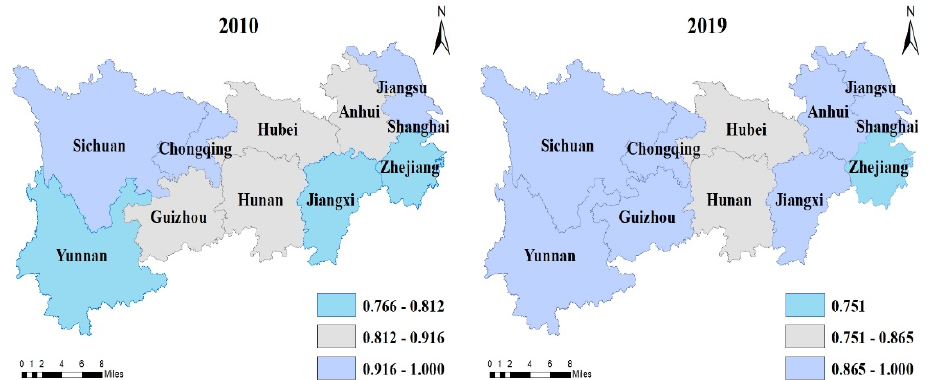
Figure 3. The temporal and spatial evolution of agricultural technical efficiency in the YREB.